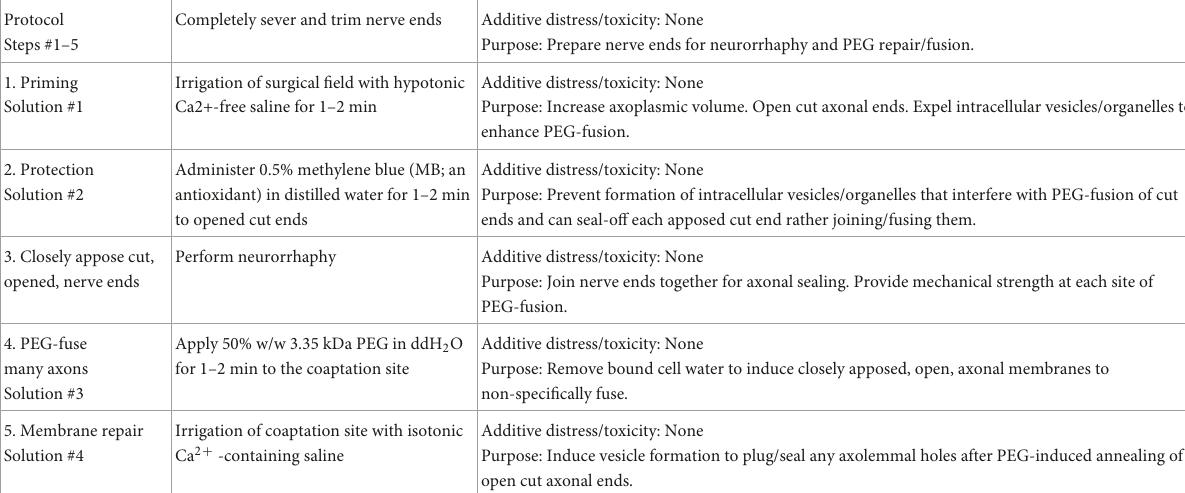
TABLE 1 Polyethylene glycol (PEG)-fusion protocol for repairing singly cut peripheral nerve injuries (PNIs). Protocol Steps